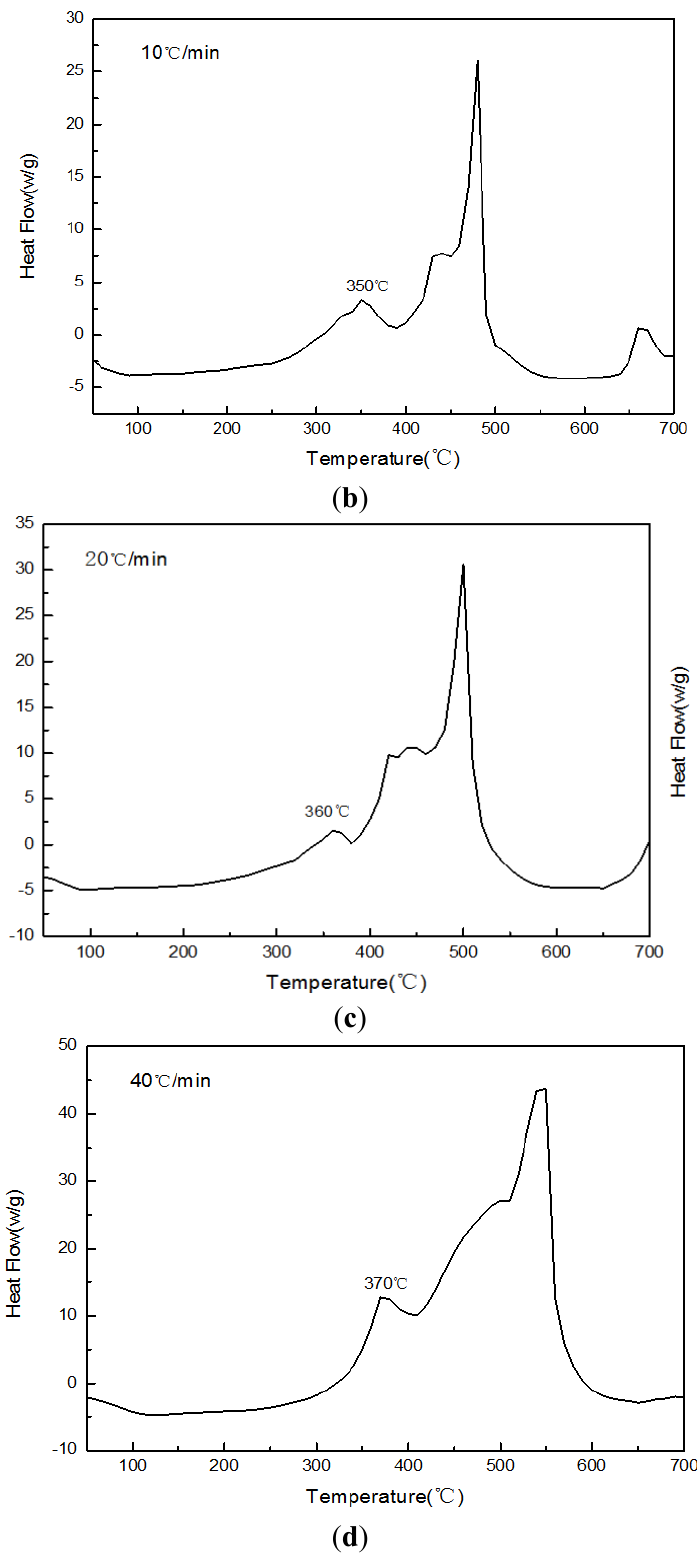
Figure 14. The DSC curves of Sample 5 paraffin-based fuel in different heating rates. ( a ) A heating rate of 5 °C/min; ( b ) a heating rate of 10 °C/min; ( c ) a heating rate of 20 °C/min; ( d ) a heating rate of 40